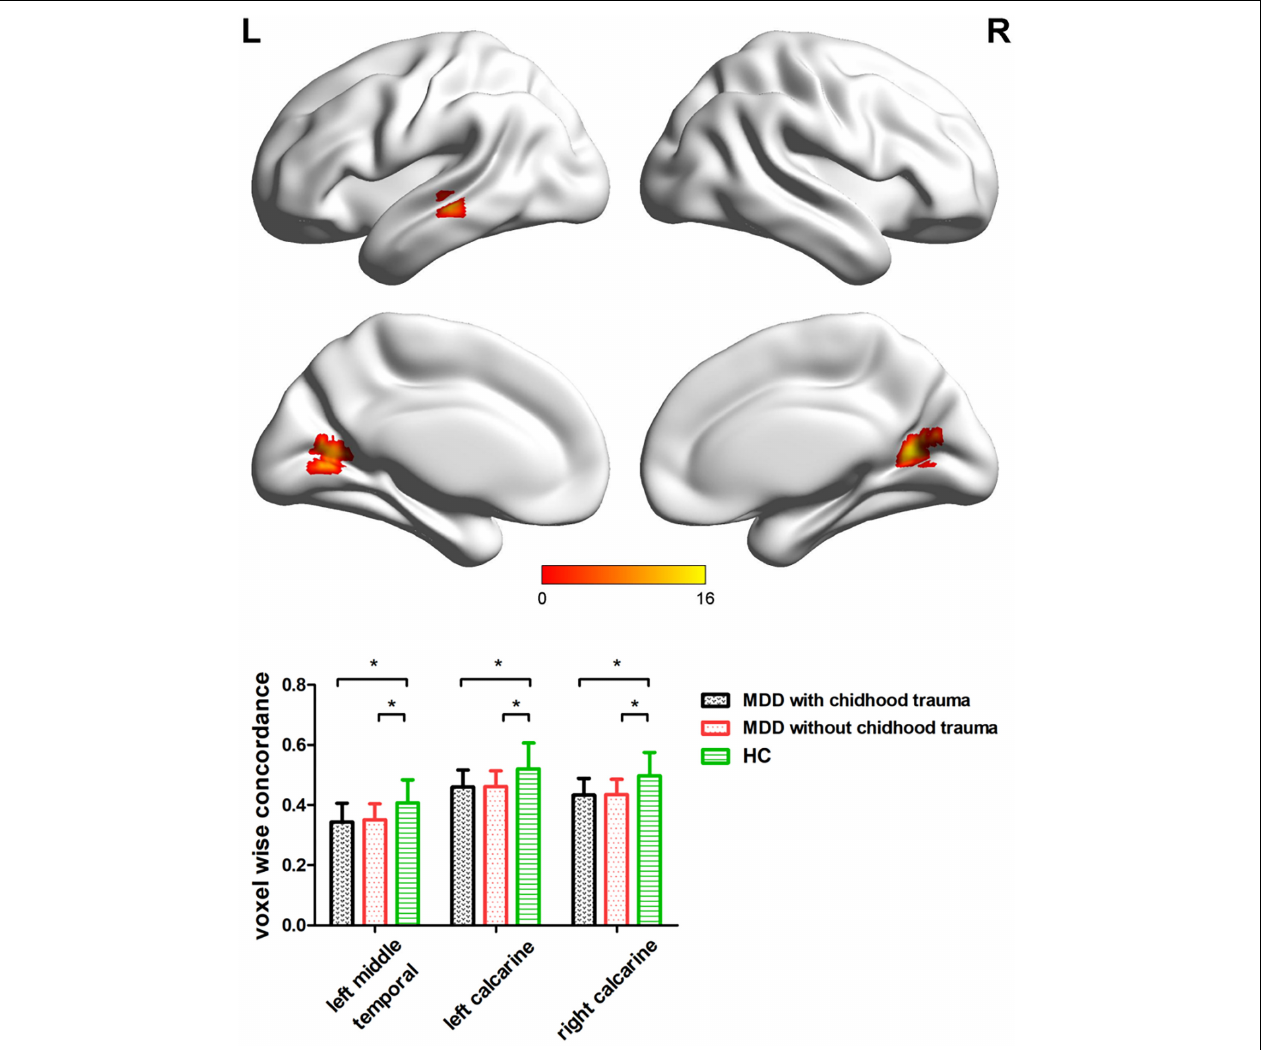
FIGURE 3 | Regions with differences in the voxel wise concordance of R-fMRI indices among the MDD with childhood trauma, MDD without childhood trauma, and HC groups and post-hoc analysis. MDD, major depressive disorder; HC, healthy control. * means the p -value has reached a significant level. In the multiple comparisons in regions with differences in voxel-wise concordance, p < 0.05/3 = 0.016 was accepted as significant (voxel-wise concordance analysis resulting in three significant clusters).